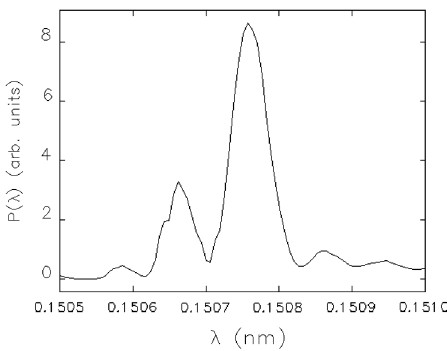
FIG. 11. FEL power spectrum at 20 m into the